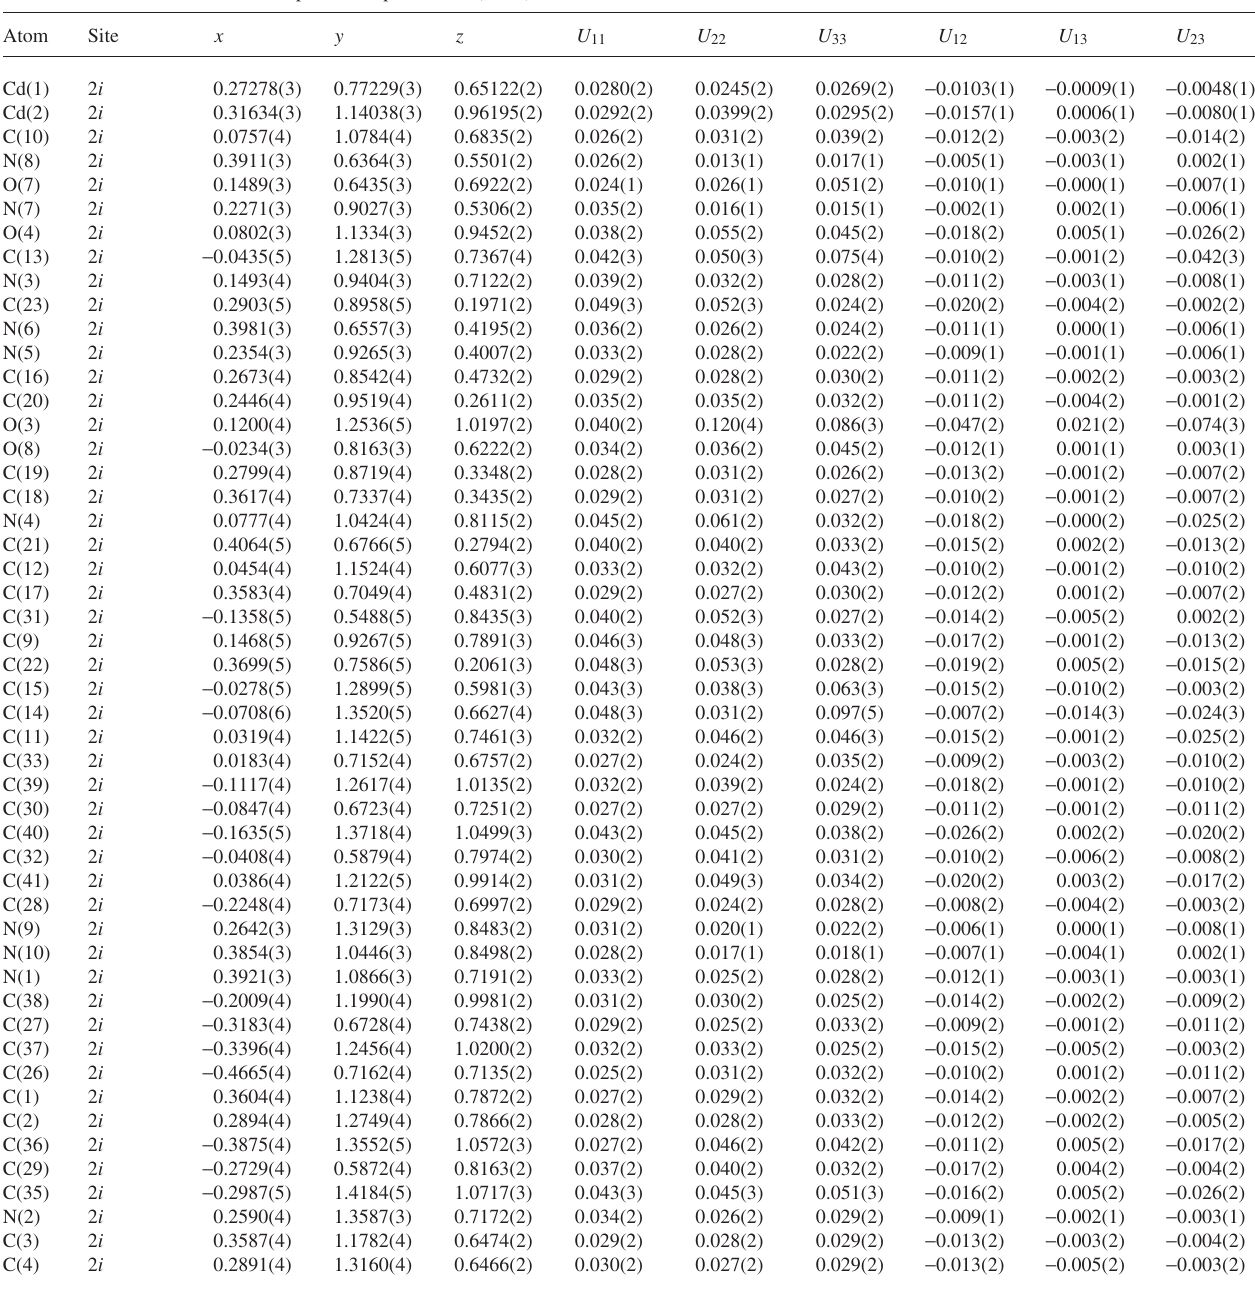
Table 3. Atomic coordinates and displacement parameters (in Å 2 )